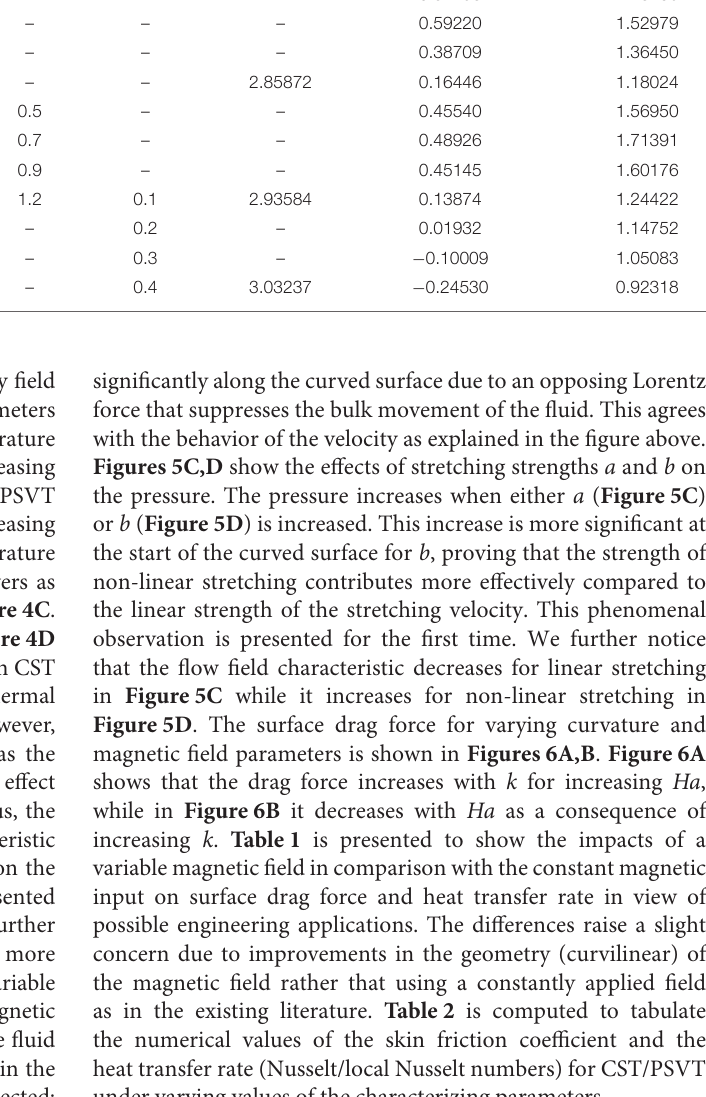
TABLE 2 | Numerical values of − R